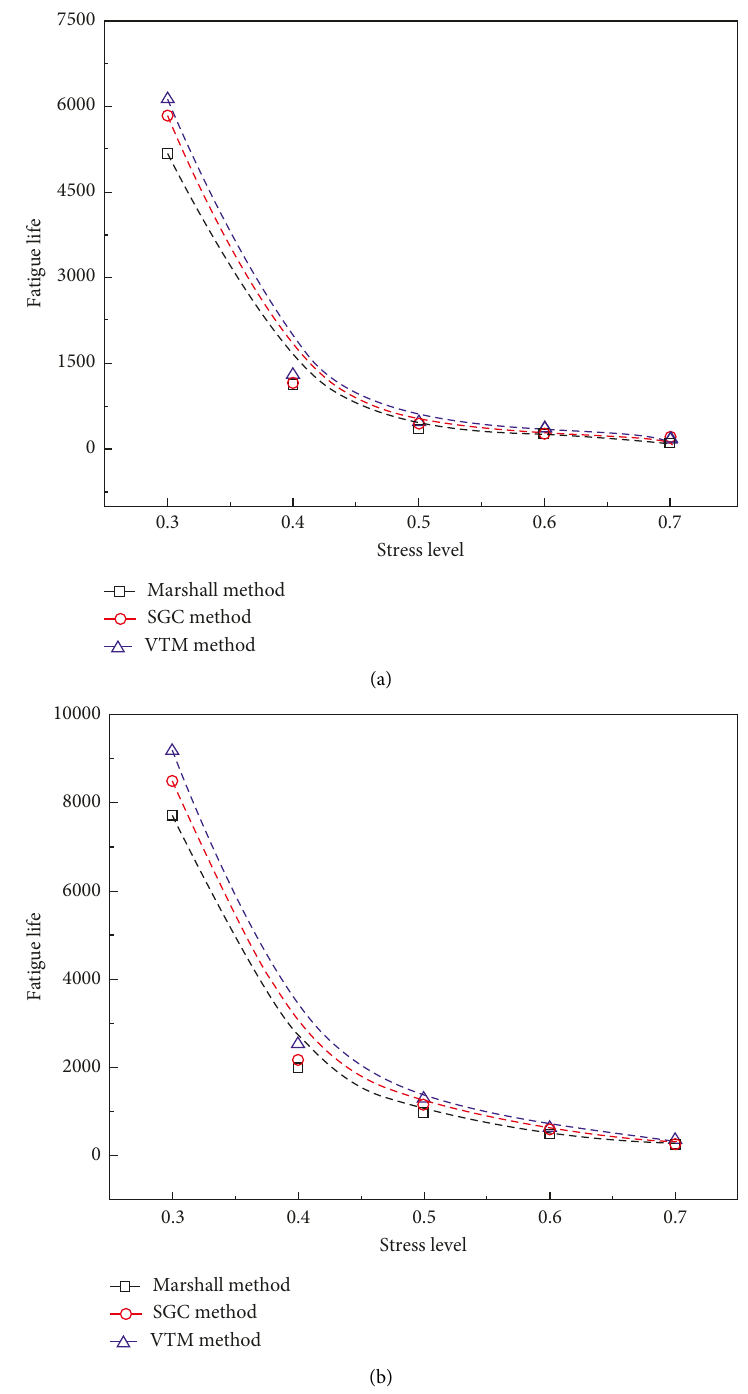
Figure 8: Fatigue life of the SMA-13 mixture with specification gradation versus stress level under different probabilities of failure. (a) Probability of failure is 5%. (b) Probability of failure is